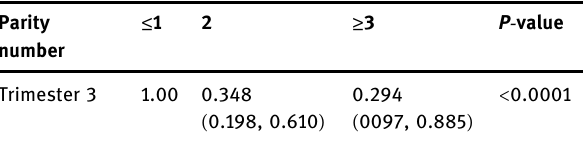
Table 5: The correlations between parity and term premature rup